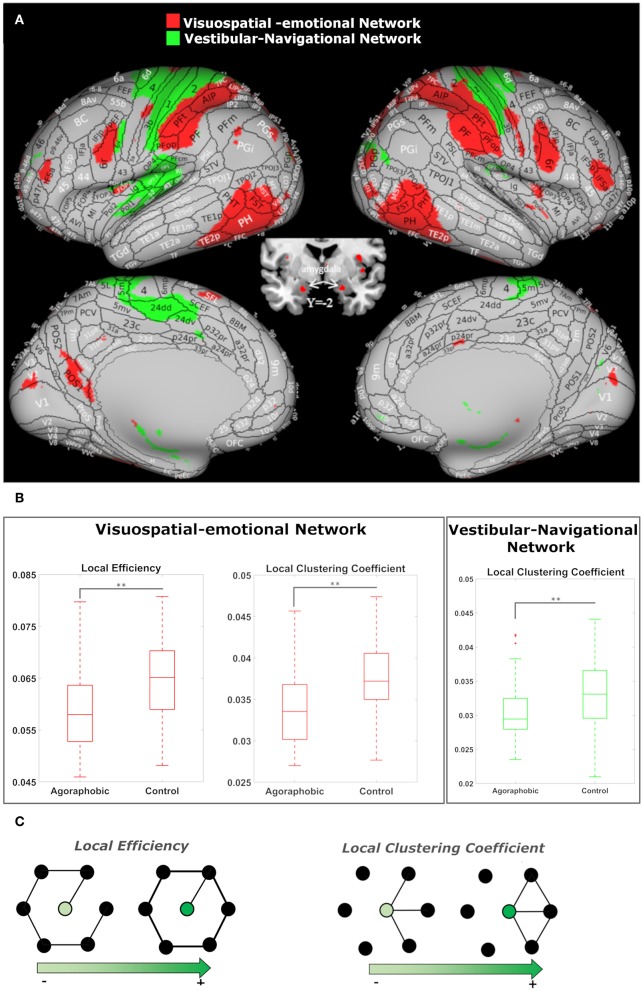
(A) The visuospatial-emotional network [node 23, shown in red on the inflated brain (66)] and vestibular-navigational network (node 41, in green) showed reduced clustering coefficients in patients with subclinical agoraphobic symptoms compared to the control group. The visuospatial-emotional network also had a lower efficiency subjects with agoraphobic symptoms. ICAs include values higher than the 98'th percentile. (B) The median value (line), quartiles (boxes), and extremes (whiskers) of the local metrics for both nodes are shown. The comparisons between the two subject groups were performed using non-parametric Mann-Whitney U tests. P-values were corrected for the number of nodes (100) using FDR (p-value** < 0.01). (C) Examples of networks in which local efficiency and clustering coefficient vary as a function of connections.